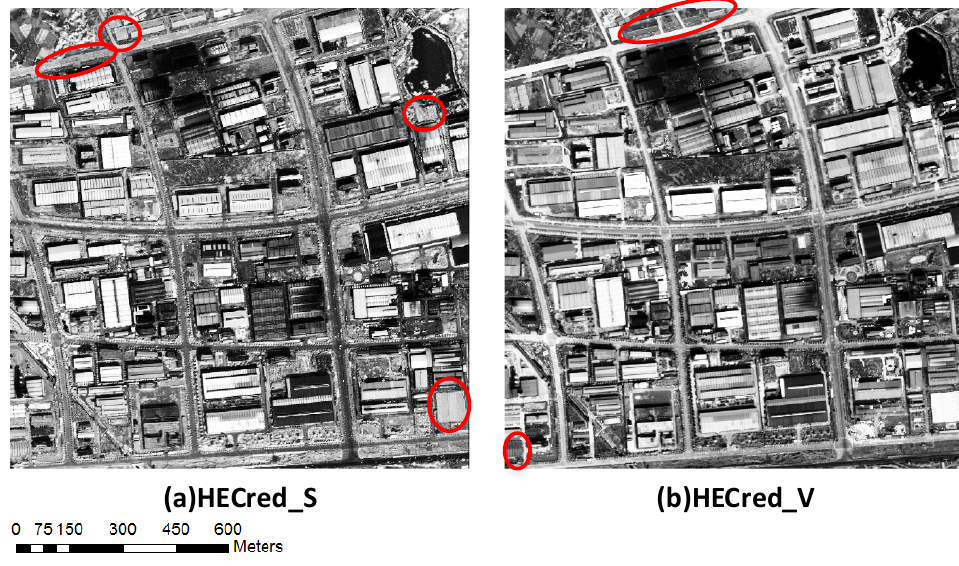
Table 4. The statistics of pixel values of the specific areas in the image of HECred_S of two cases. The specific areas were the omission areas of SGD, SCM, CDSS and the delineated changes areas.